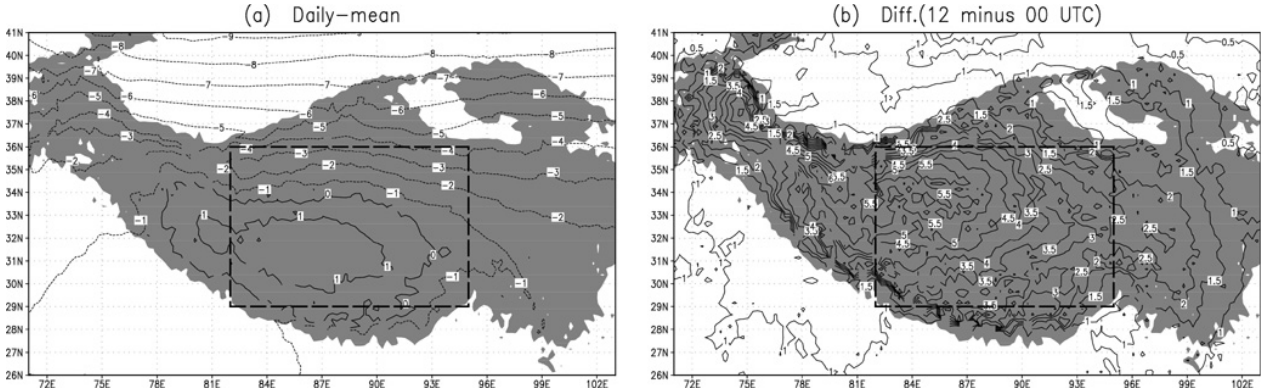
Fig. 7. 500hPa temperature ( ◦ C): (a) daily-mean, (b) difference between 12:00 and 00:00UTC. The shaded areas are above 3000m, and the dashed rectangles represent the central plateau.